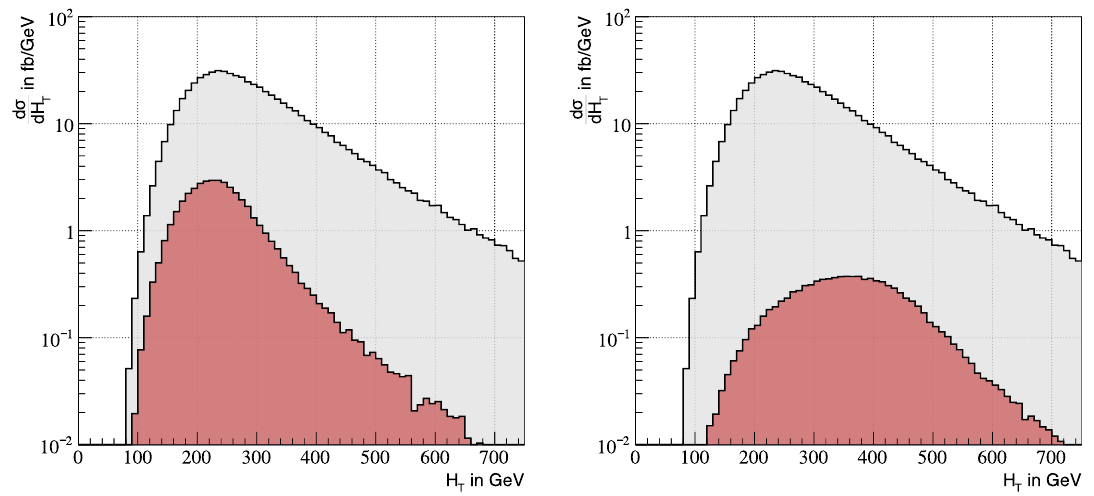
Figure 10 . Binned differential cross-section in the signal region for g tb = 0 . 6 , g cb = 0 . 4 and √ s = 14 TeV@140 fb − 1 , as a function of the sum of transverse momenta H T for m (left panel) m = 500 GeV (right H ±